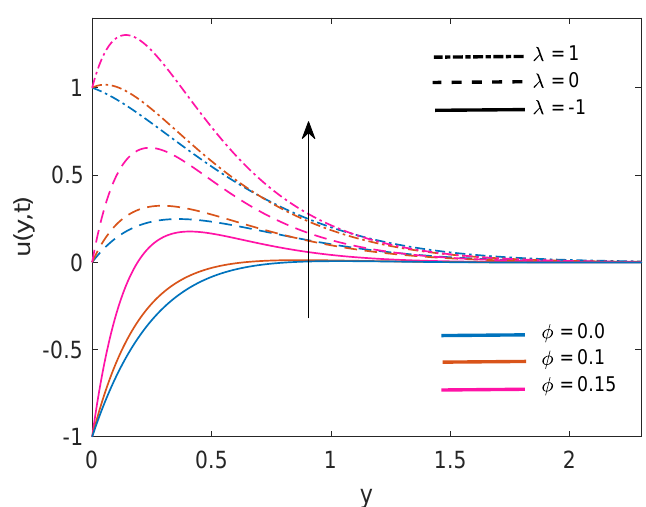
Figure 8. Variation in velocity profile for different φ when Nr = 1.5, Gr = 5, K = 5, Q = 0.5, M 2 = 5 and t = 0.5.